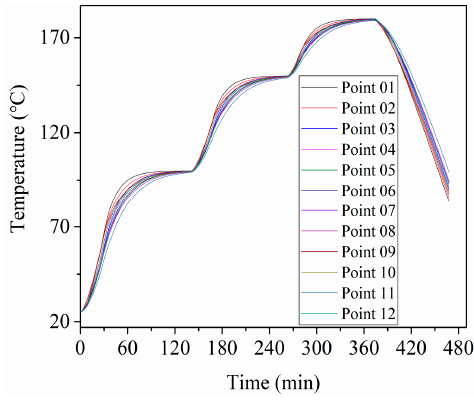
Figure 9. The simulation results of 12 points.